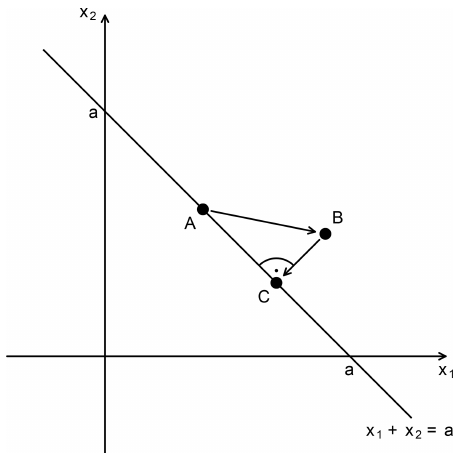
Figure 3. Two-dimensional illustration of one iteration of the mod- ified MBCn algorithm used for statistical downscaling in ISIMIP3 (MBCnSD), which at its core consists of two steps. In the first step, data point A is quantile-mapped to data point B like in the original MBCn algorithm. In the second step, MBCnSD projects data point B onto the weighted sum-preserving hyperplane of data point A , here with equal weights on all axes. The result is data point C .